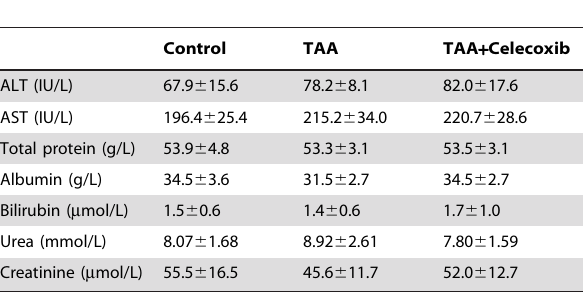
Table 2. Effects of celecoxib on the liver and renal